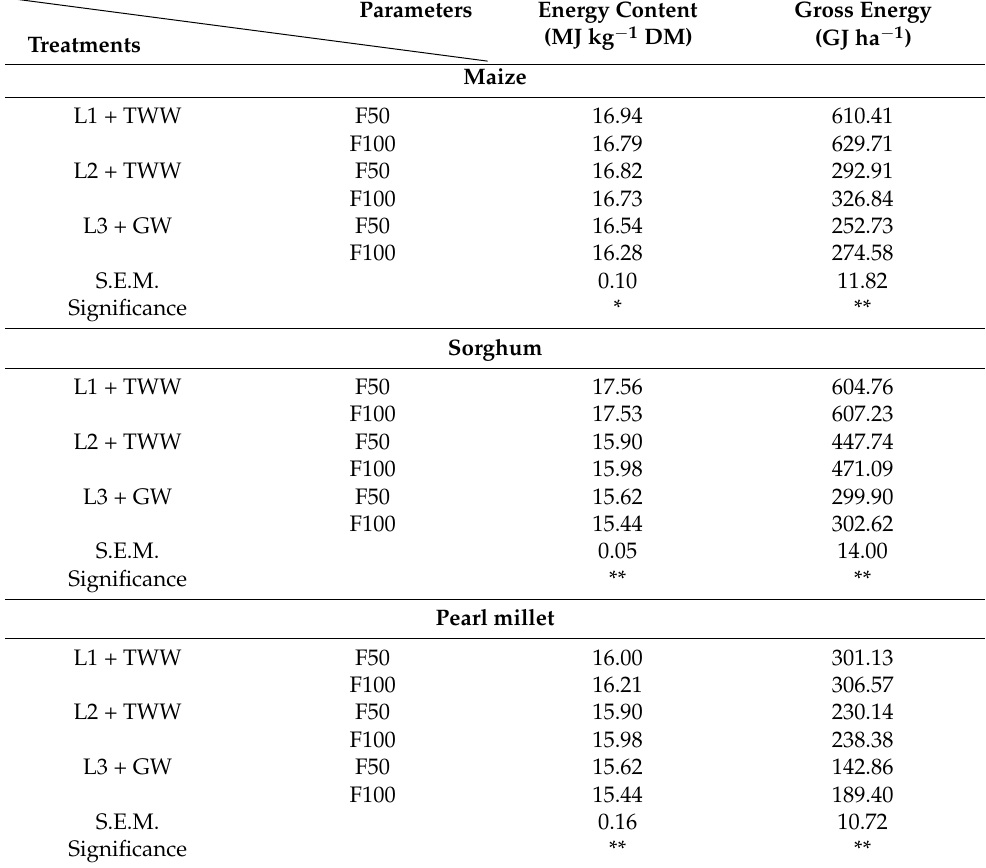
Table 7. Interaction effects of water resources and fertilization treatments on energy traits of maize, sorghum, and pearl millet.